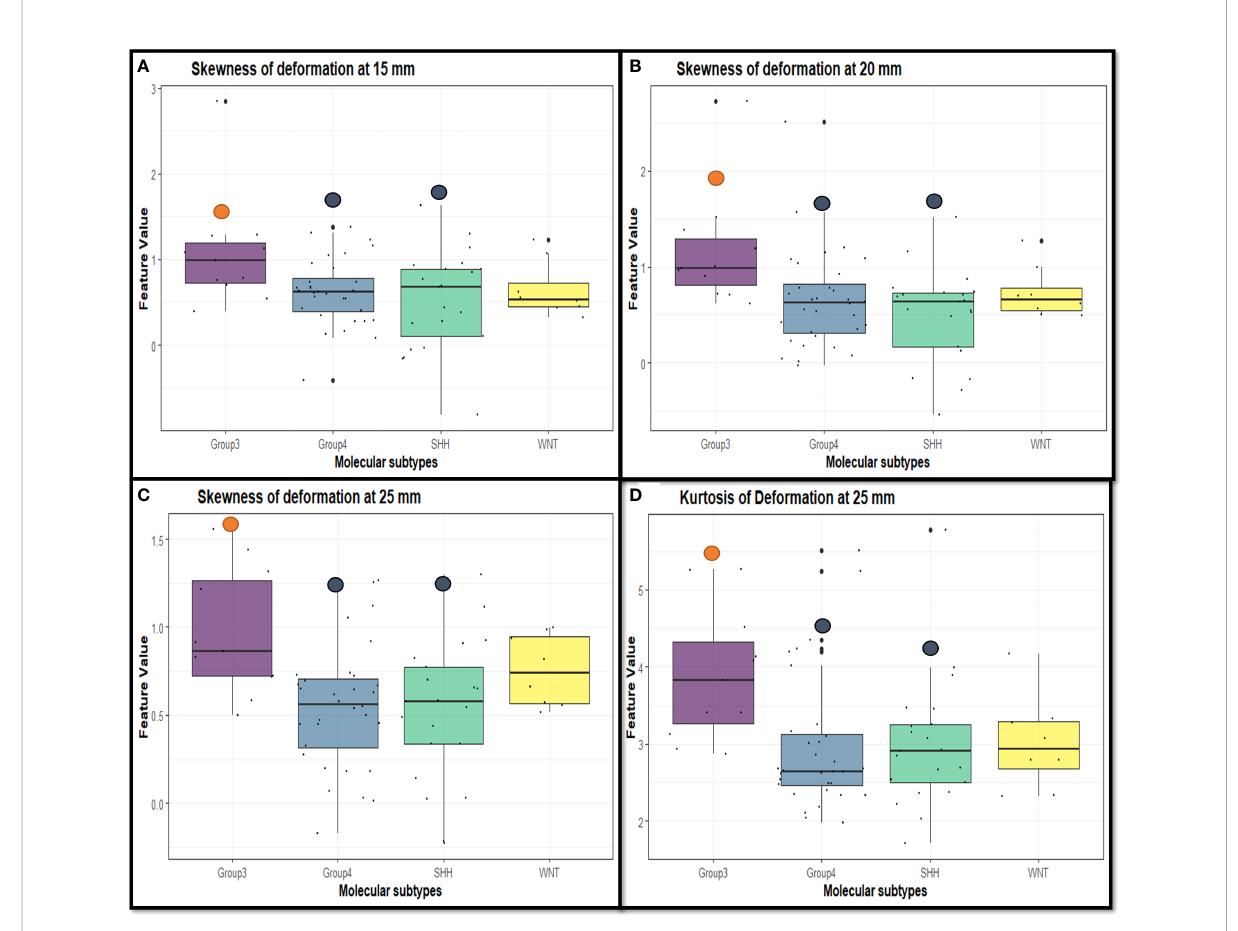
FIGURE 2 Box plots representing the top deformation features that were found to be discriminative between the MB subgroups. Speci fi cally, skewness of deformation was statistically signi fi cant at (A) 15 mm between Group 3 vs. SHH and Group 4 (p-value = 0.028), (B) 20 mm between Group 3 vs. SHH and Group 4 (p-value = 0.007), and (C) 25 mm between Group 3 vs. SHH and Group 4 (p-value = 0.004). Kurtosis of deformation was statistically signi fi cant at (D) 25 mm between Group 3 vs. SHH and Group 4 (p-value =